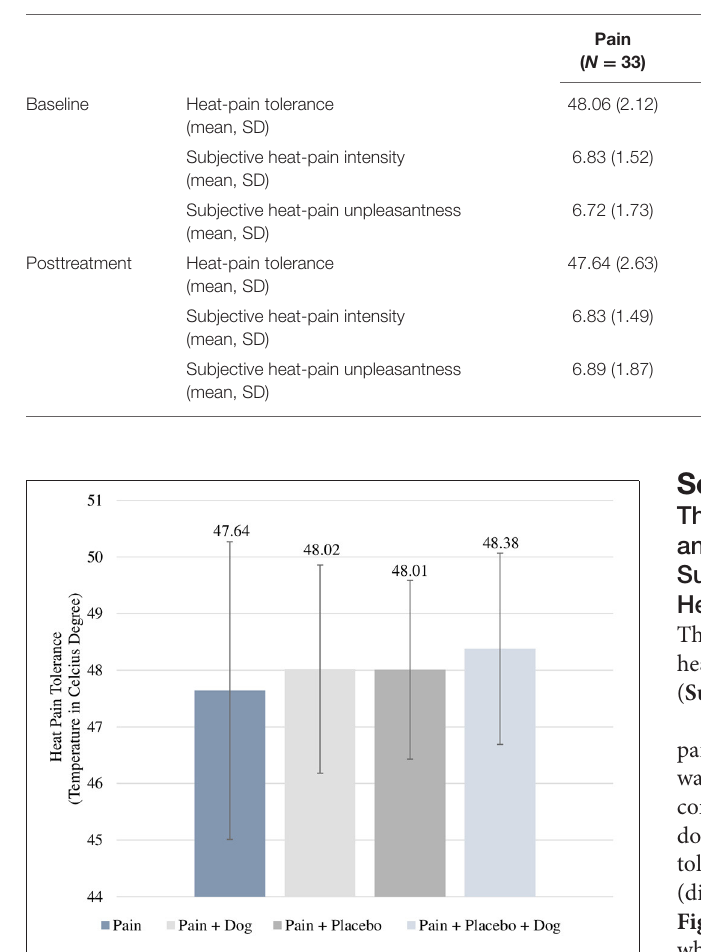
FIGURE 2 | Posttreatment mean scores of heat-pain tolerance. For each condition, the respective mean and standard deviation are displayed.